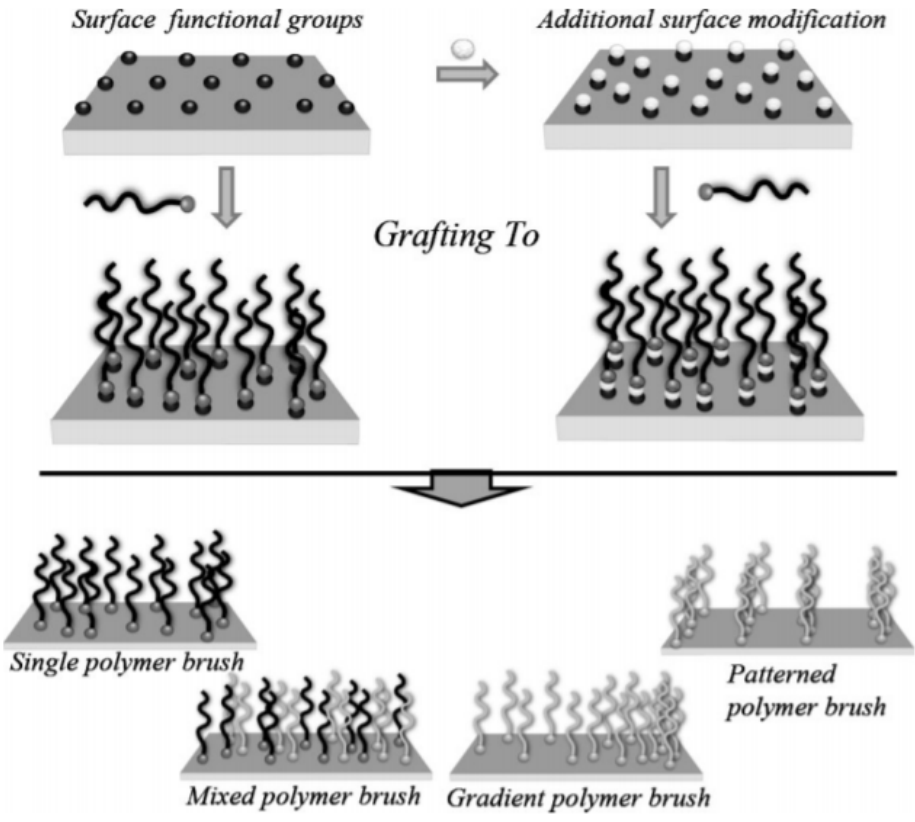
Figure 3. Schematic representation of the grafting-to method (reprinted with permission from [32], Copyright 2011, John Wiley & Sons).